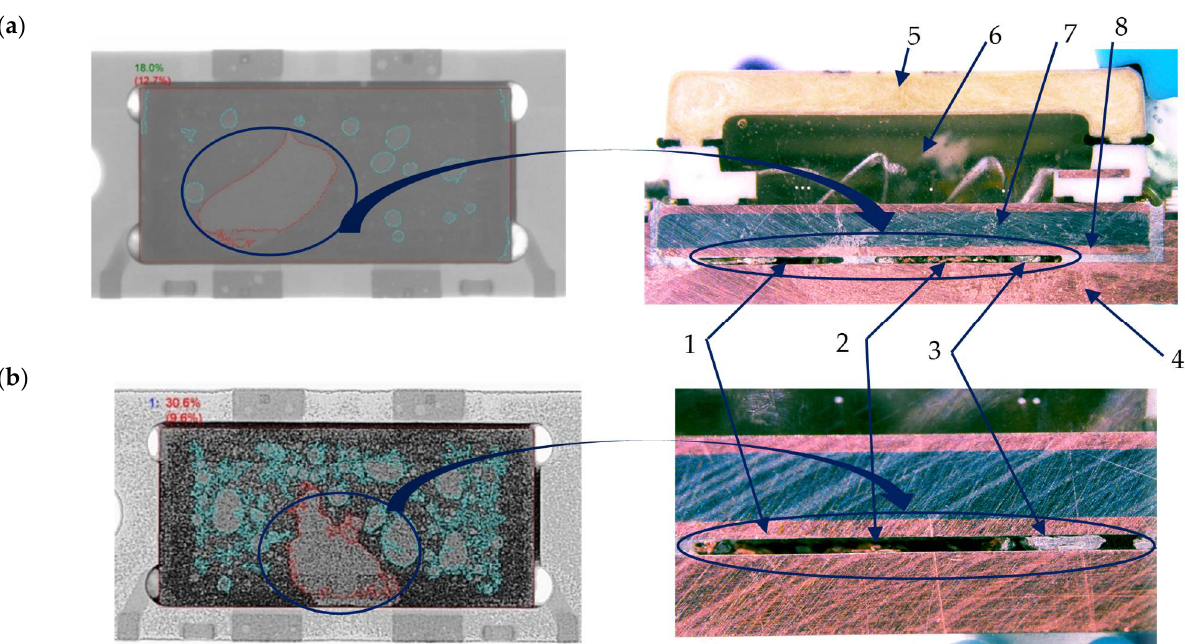
Figure 3. X-ray images of the area of the soldered joint and microscopic cross-section photos of such a joint for a big individual void ( a ) and many small voids ( b ): 1—black color means voids; 2—golden color means remnants, pollen due to the cross-section; 3—silver color—solder joint; 4—PCB layer; 5—transistor case; 6—active area of the transistor; 7—source active layer; 8—golden source electrode.